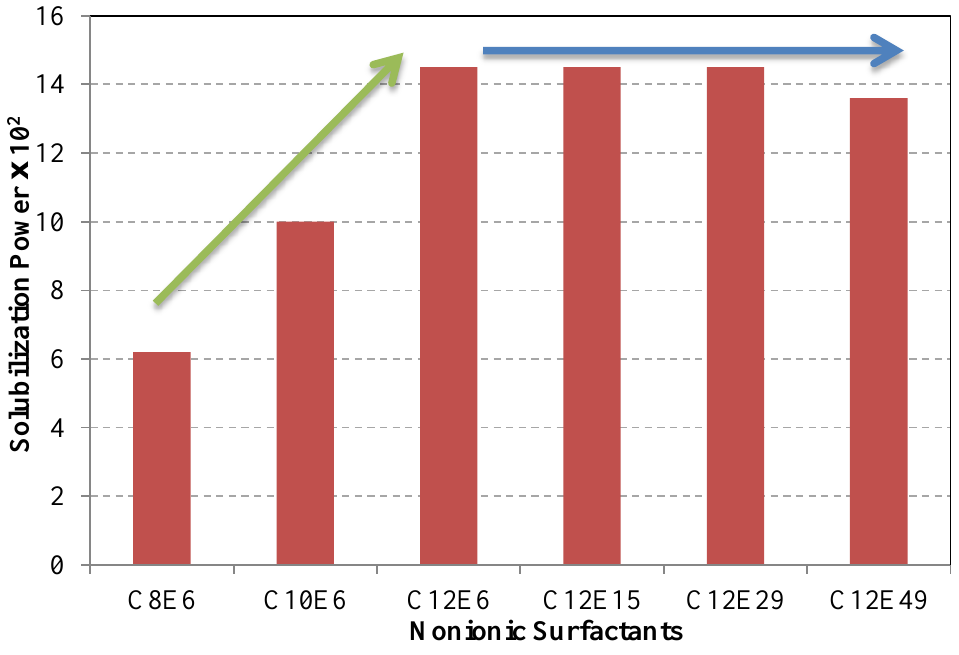
E ; n = 8,10,12, m = 6,15,29,49) at 30  C. Data from [59]. n m